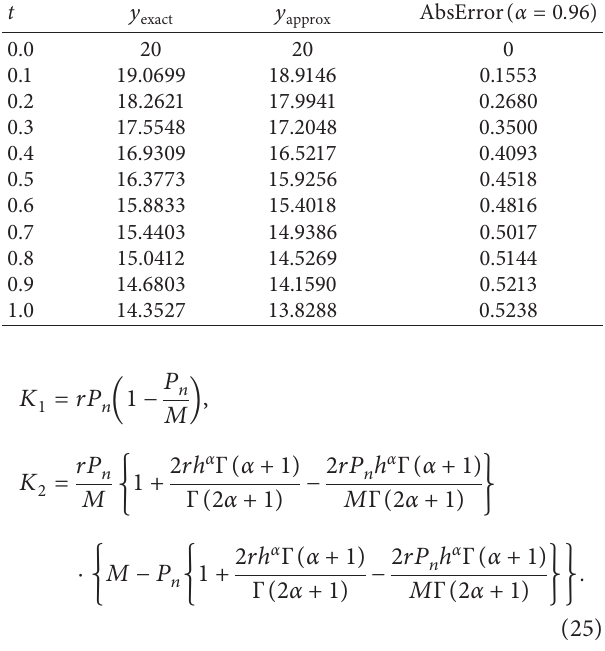
Table 6: Numerical results of Example 3 for α � 0 . 96, with mesh size h � 0 .